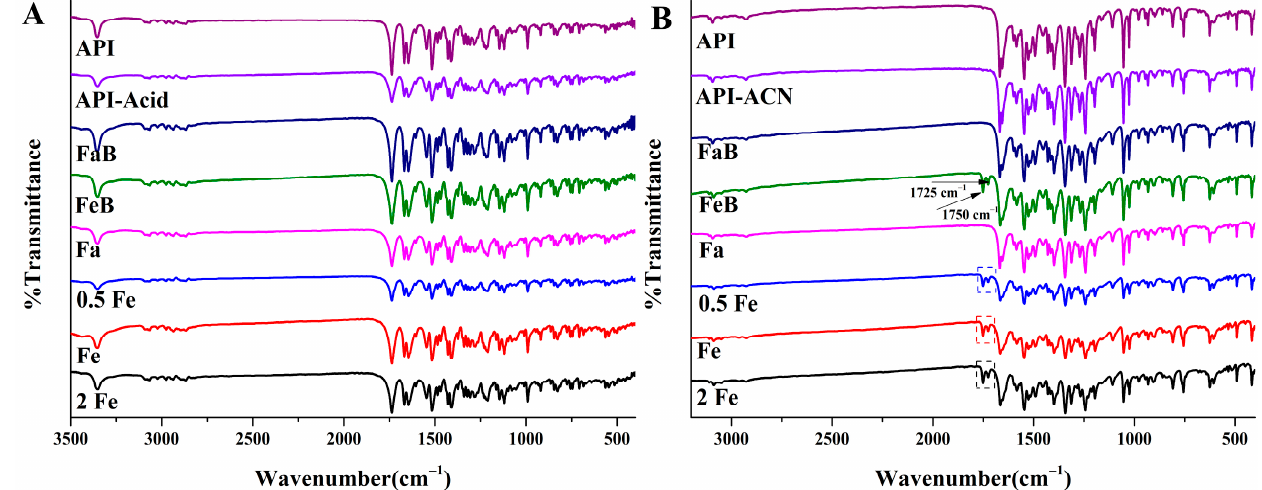
Figure 3. Fourier transform infrared spectrum of API and different precipitates. ( A ): Rivaroxaban; ( B ): Drug-A. (API-Acid/API-ACN, FaB, FeB, Fa, 0.5 Fe, Fe, and 2 Fe indicate that precipitate comes from the medium of organic solvent, FaSSIF buffer, FeSSIF buffer, FaSSIF, 0.5 × FeSSIF, FeSSIF, and 2 × FeSSIF, respectively).